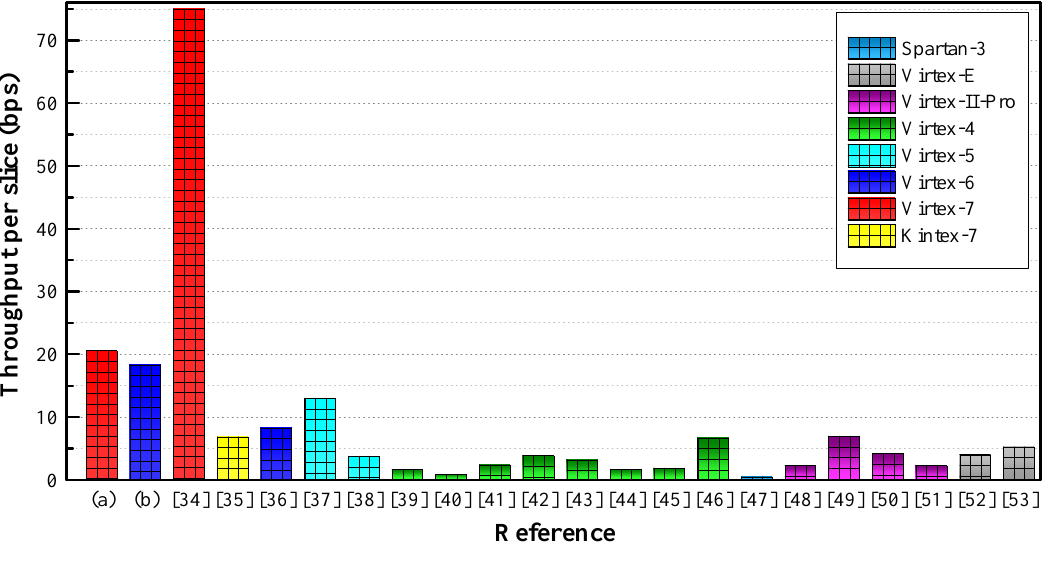
Figure 10. Performance comparison in terms of throughput per